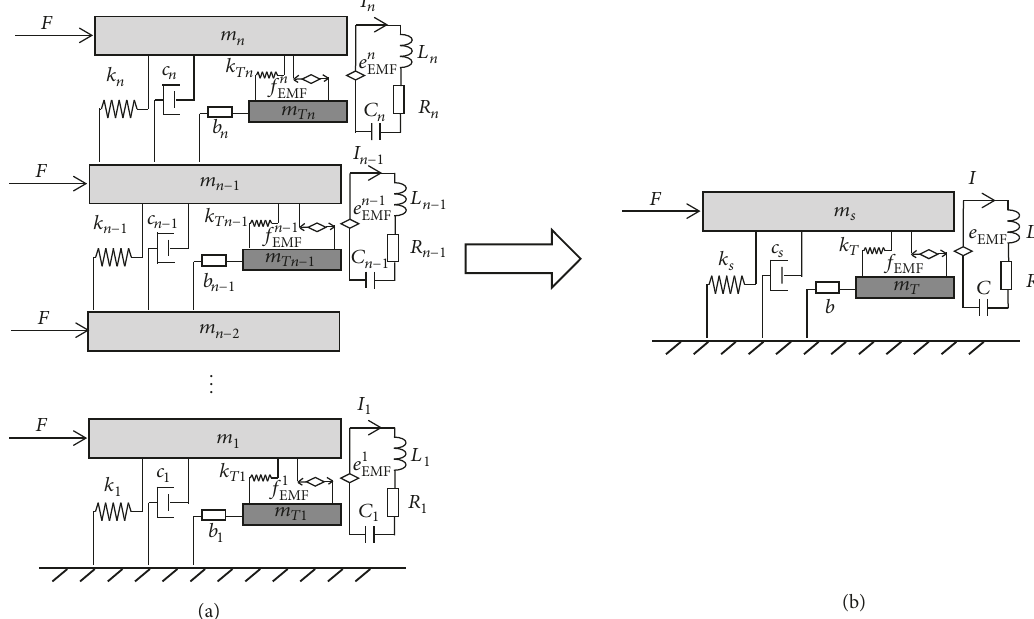
Figure 1: Schematic of the coupled structure and tuning damper system: (a) a general MDOF and (b) the SDOF structure-damper system.